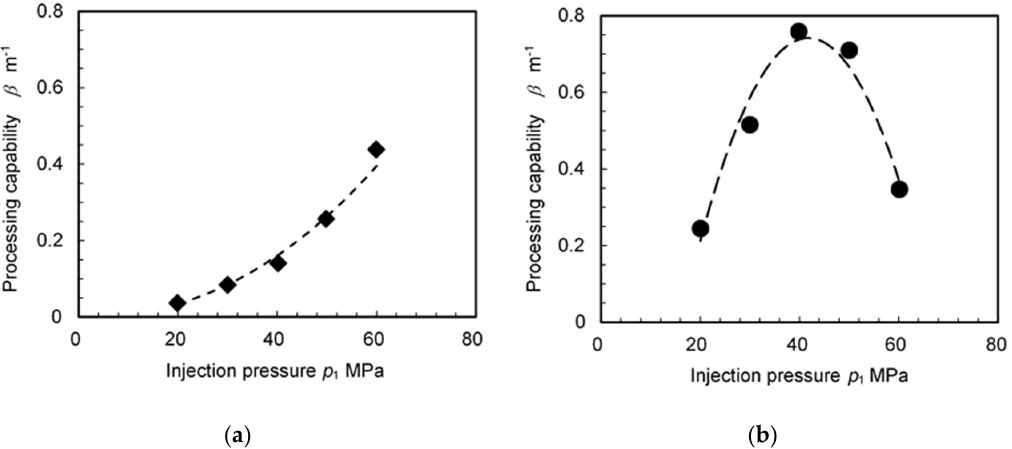
Figure 19. Processing capability as a function of injection pressure [97]. Reproduced with permission from The Water Jet Technology Society of Japan; ( a ) Water jet peening; ( b ) Cavitation peening.